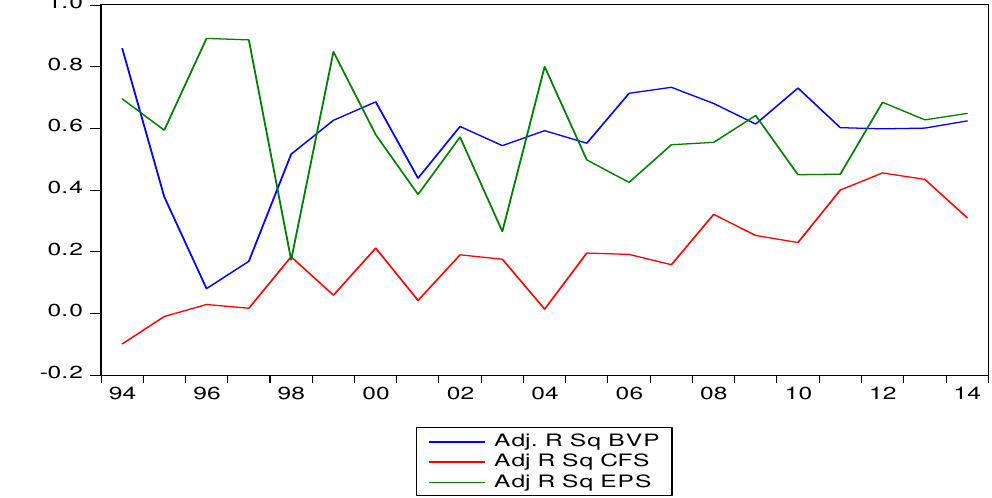
Fig. 1. Graphical view of the value relevance of book value, cash flow and earnings book value is a value relevant variable, as it Table 4 presents the OLS regression results which explained a fraction of the variation in stock prices are used to test the value relevance of book values, for all the twenty one (21) years under study. The cash flow and earnings individually to stock prices. lowest adjusted R-square recorded is 8% in 1996 Book value explained about 49.64% of stock price and the highest adjusted R-square recorded variance in pooled data. Yearly data showed that